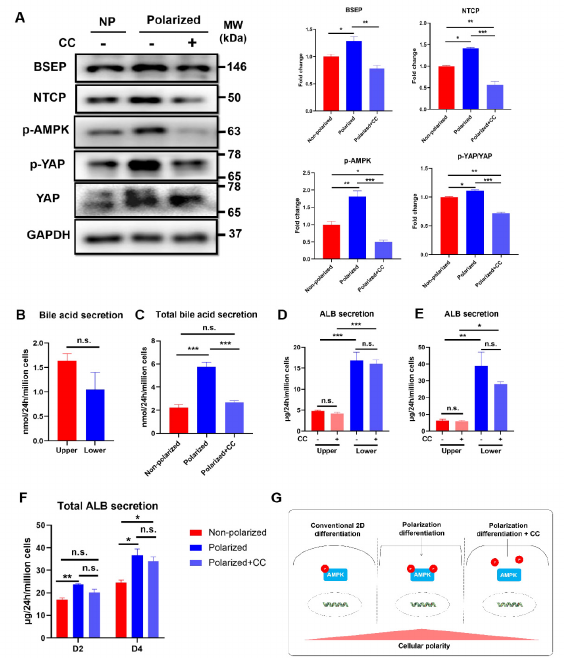
Figure 7. Activation of AMPK signaling pathway involved in the polarity maintenance in the polarized hEHs ( A ) Western blot analysis of cell lysates from the nonpolarized and polarized hEHs in the presence or the absence of CC for determining the protein expressions of BSEP, NTCP and phosphorylations of AMPK and YAP (left panel), quantification of these protein levels normalized to GAPDH protein (right panel). Full-length blots were presented in Supplementary Figure 3S. ( B ) Analysis for the directional secretion of the bile acids in the polarized hEHs treated with CC for 4 days. ( C ) Analysis for the total bile acid secretion of the non-polarized hEHs and polarized hEHs in the presence or the absence of CC for 4 days. ( D ) Analysis for directional ALB secretion of non − polarized and polarized hEHs in the presence or the absence of CC for 2 days. ( E ) Analysis for directional ALB secretion of non-polarized and polarized hEHs in the presence or the absence of CC for 4 days. ( F ) Analysis for the total ALB secretion of non-polarized and polarized hEHs in the presence or the absence of CC for 2 days and 4 days. ( G ) Schematic representation of the activation of the AMPK signaling pathway involved in the polarity maintenance in the polarized hEHs. Data represent the mean ± SD. * p < 0.05, ** p < 0.01, *** p < 0.001; n.s. means no significant.